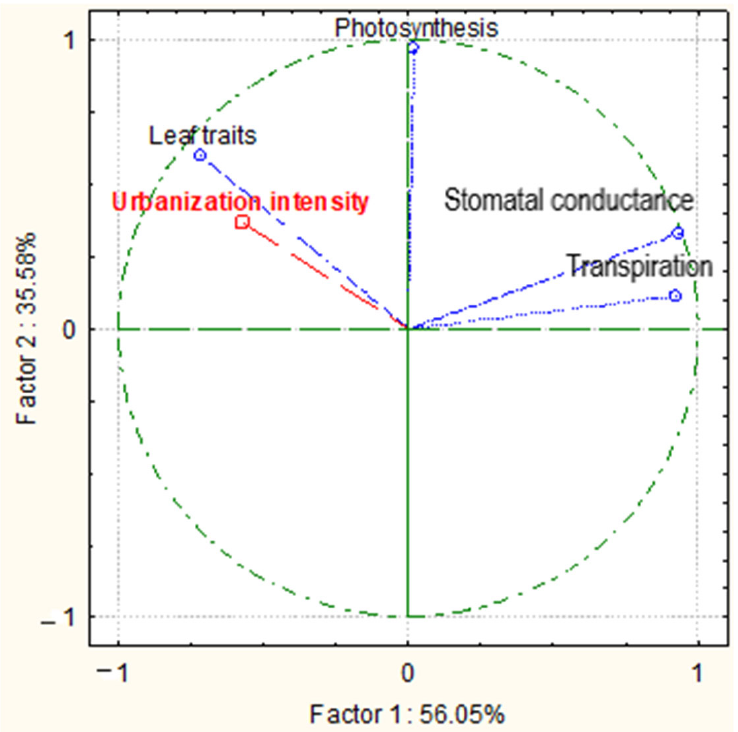
Figure 4. Physiological plant traits: ( a ) intensity of photosynthesis (A, µmol m − 2 s − 1 ), ( b ) stomatal conductance (Gs,µmol m − 2 s − 1 ), and ( c ) intensity of transpiration (E, µmol m − 2 s − 1 ) in August 2020— six years after transplantation into the urban environment. Values with di ff erent le tt ers indicate sig- ni fi cant di ff erences ( p < 0.05).